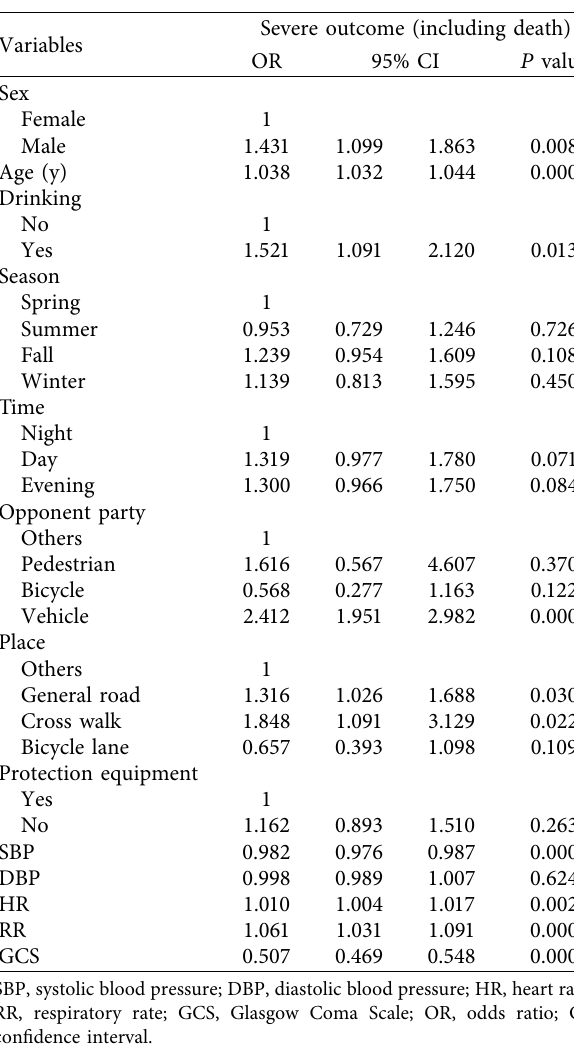
Table 3: Association between severe outcome and other variables using multivariate logistic regression.